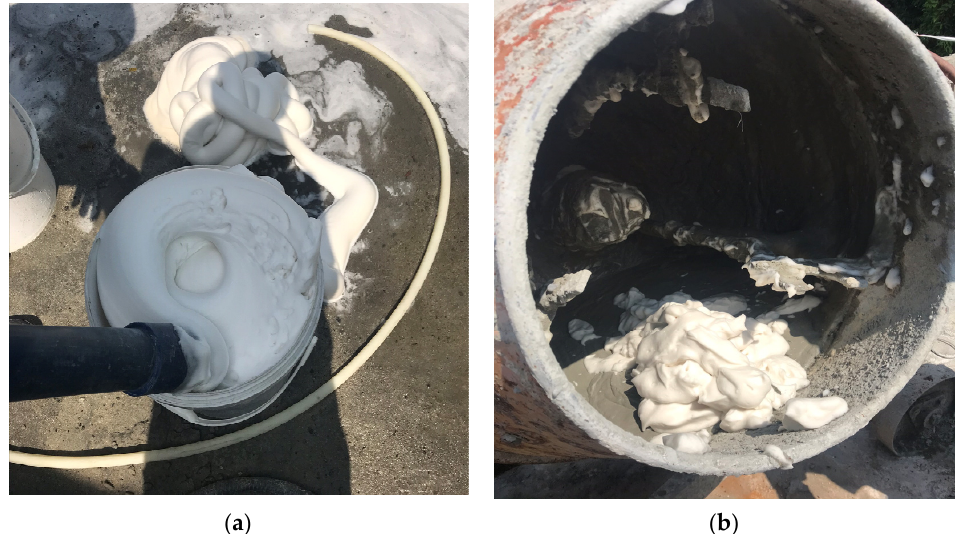
Figure 2. Preparation of LFC mixture. ( a ) preparation of stable foam. ( b ) adding foam into mortar slurry.